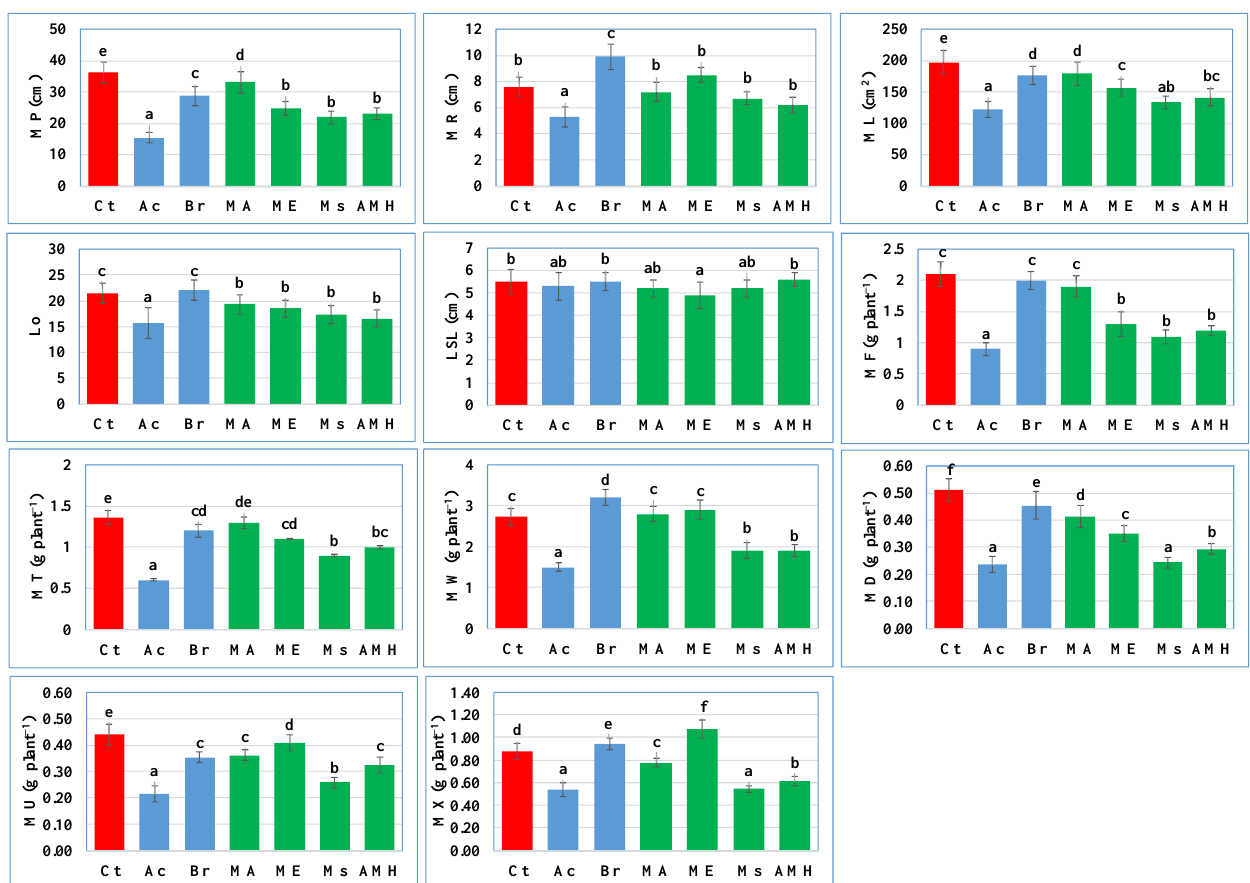
Figure 1. Morphological characteristics of Dactyloctenium aegyptium treated with pre- and post-emergence herbicides. Means sharing same lowercase letters on bars are statistically non−significant at p ≤ 0.05%). Red bar indicates control group, blue bars show pre-emergence and green bars are used for post-emergence herbicides. For abbreviations please see list at the end of manuscript.